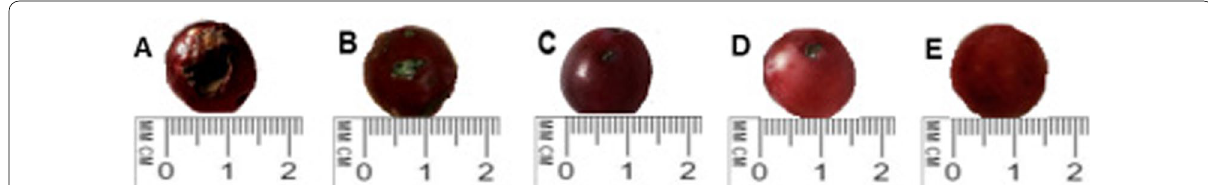
Fig. 4 In vivo protection efficacy of compound 4 and cyproconazole against B. cinerea . A Blank control; B Positive control (cyproconazole, 2.5 μg/ mL); C cyproconazole, 12.5 μg/mL; D 4 , 2.5 μg/mL; E 4 , 12.5 μg/mL